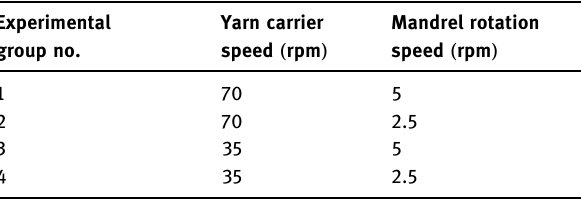
Table 1: Technical parameter settings for each group Experimental group no.